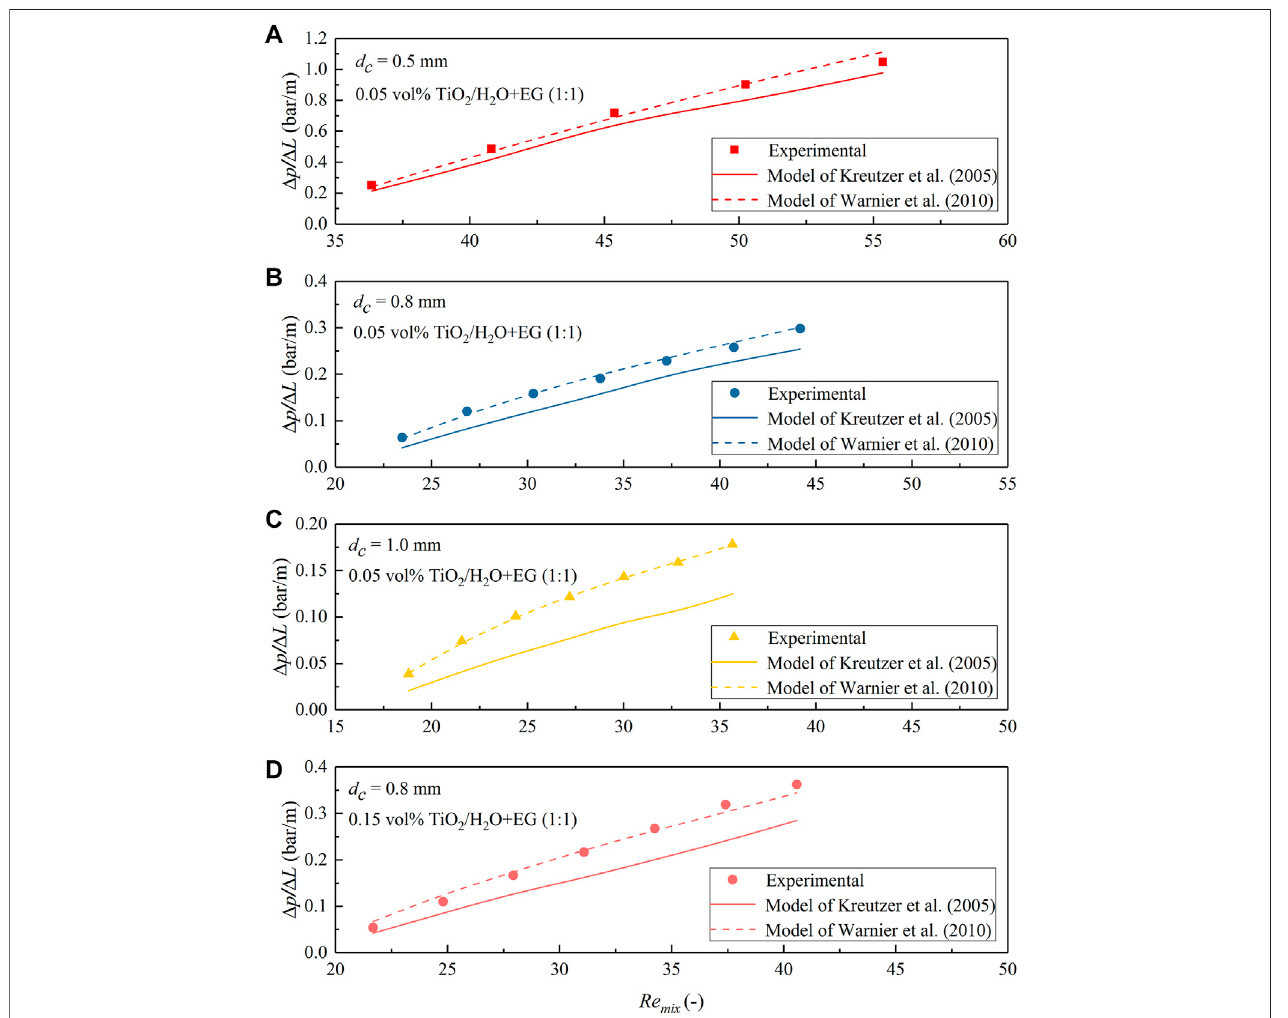
FIGURE 15 | Comparison of the measured pressure drop data for N 2 – TiO 2 /H 2 O + EG (1:1) nano fl uid slug fl ow in the microchannel with predictions according to the model of Kreutzer et al. (2005) and Warnier et al. (2010). (A) d c (cid:1) 0.5 mm, φ (cid:1) 0.05 vol%; (B) d c (cid:1) 0.8 mm, φ (cid:1) 0.05 vol%; (C) d c (cid:1) 1.0 mm, φ (cid:1) 0.05 vol%; (D) d c (cid:1) 0.8 mm, φ (cid:1) 0.15